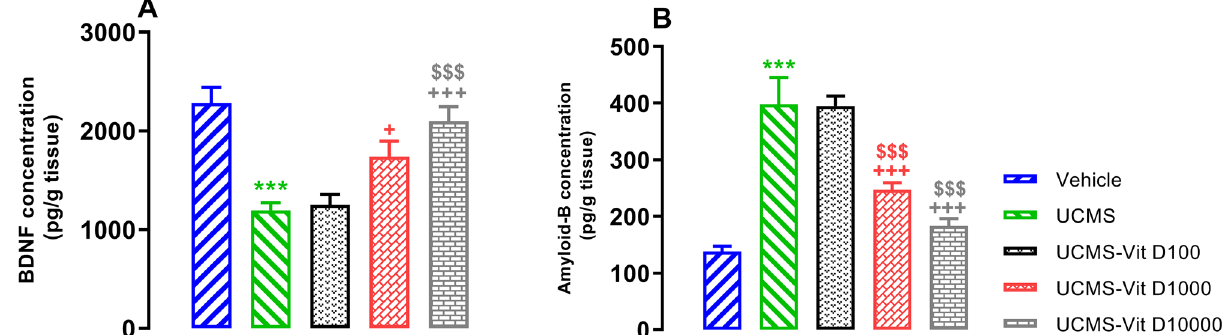
Figure 7. Hippocampal concentrations of Aβ ( A ) and BDNF ( B ). Data are presented as mean ± SEM, n = 10. *** P < 0.001 versus Vehicle group, + P < 0.05 and + + + P < 0.001 versus UCMS group, $$$ P < 0.001 versus UCMS- Vit D100